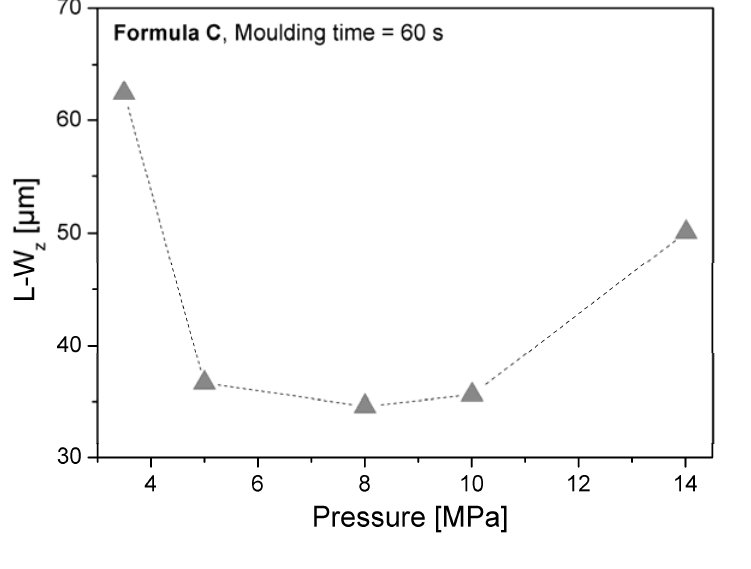
Figure 19. Effect of moulding pressure on long waviness at L